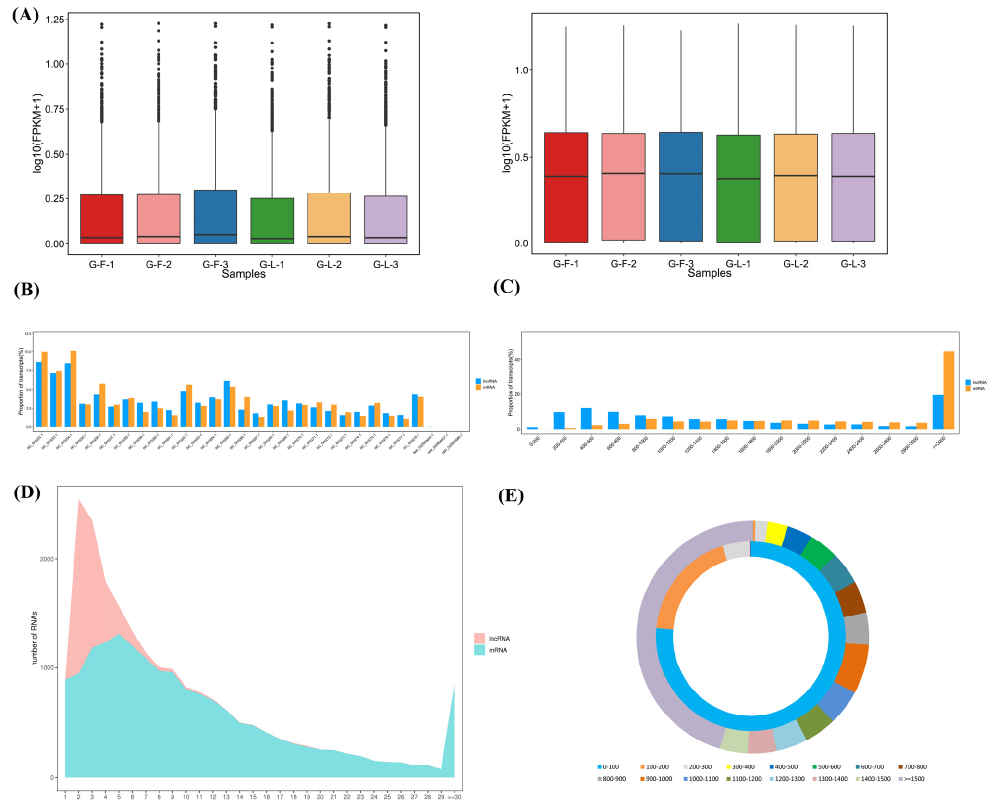
Figure 2. Comparison analysis of lncRNAs and mRNAs in sheep pituitary gland. ( A ) The boxplot shows the sample expression levels (log 10 (FPKM)) of lncRNAs and mRNAs in the H-F and H-L groups. ( B ) The chromosome distribution of lncRNAs and mRNAs. ( C ) The length comparison of lncRNAs and mRNAs. ( D ) Exon content of lncRNAs and mRNAs. ( E ) Length of the open reading frame (ORF) of lncRNAs and mRNAs.